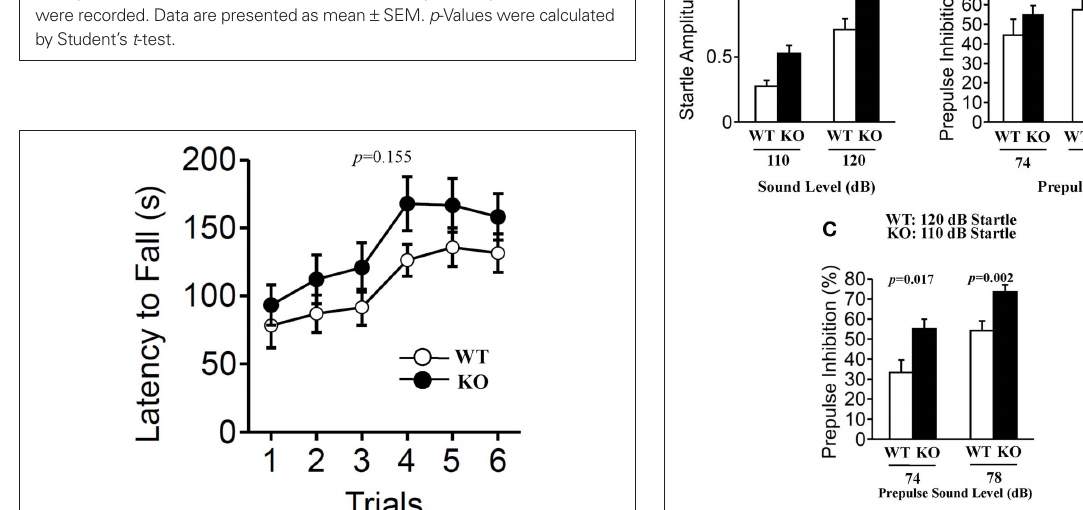
Figure 8 | Prepulse inhibition test. Prepulse inhibition was measured by a combination of startle (110 or 120 dB) and two prepulse levels (74 and 78 dB) in wild-type ( n = 20) and relaxin-3 KO ( n = 20) mice. Startle responses without prepulses (A) and prepulse inhibition of the startle reflex (B,C) were recorded. Startle response amplitude and prepulse inhibition are presented as mean ± SEM and as the mean percent reduction ± SEM, respectively. p -Values were calculated by Student’s t -test or Mann–Whitney’s